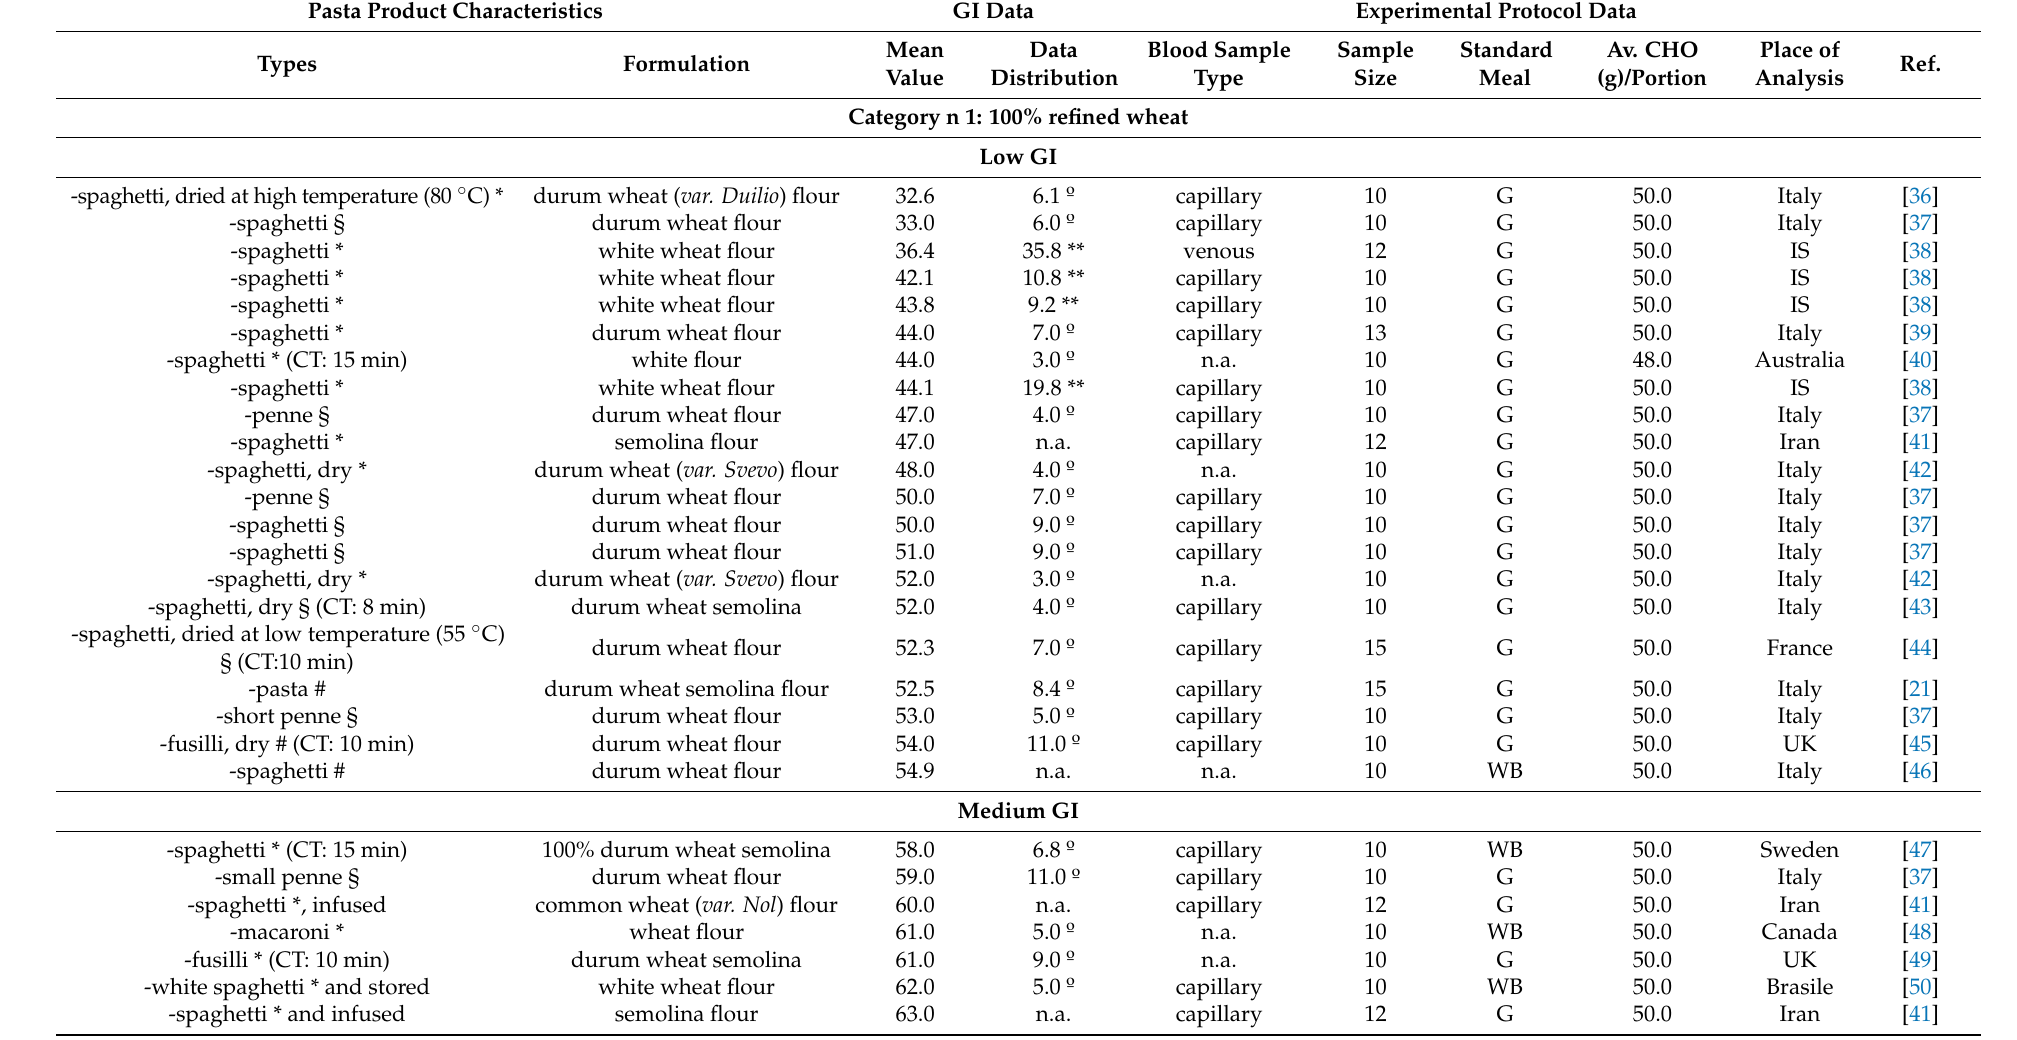
Table 1. Pasta product characteristics, glycemic index and experimental protocol data.